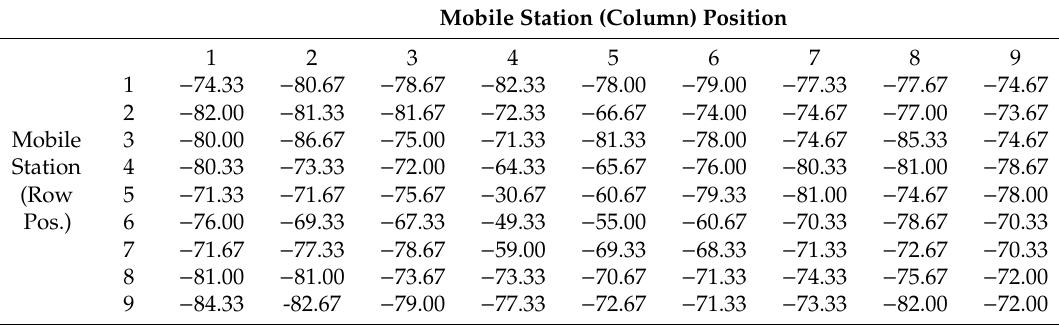
Table 2. Measured RSSI for MeS 2 (position 54: row 5, column 4).